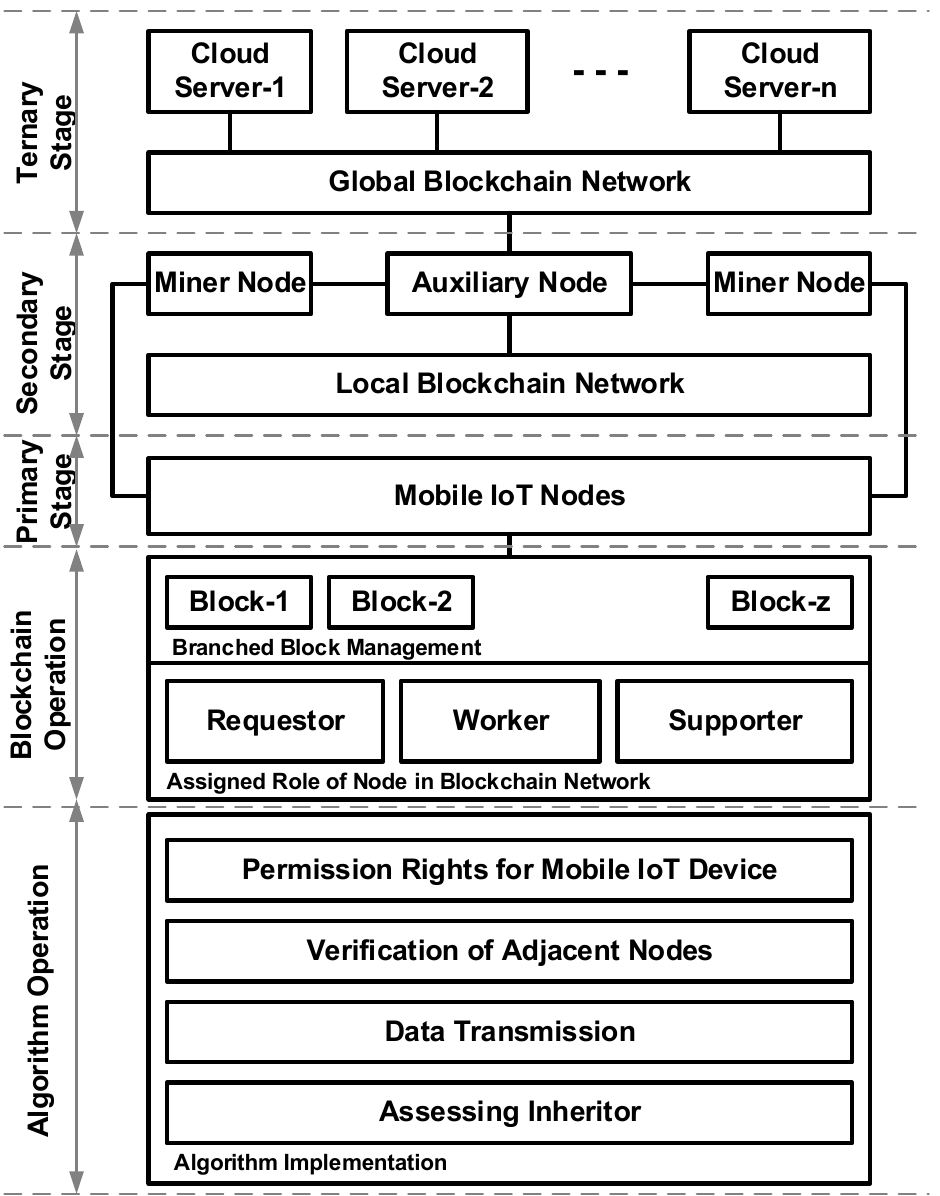
Figure 1. Proposed Figure 1. Proposed architecture.